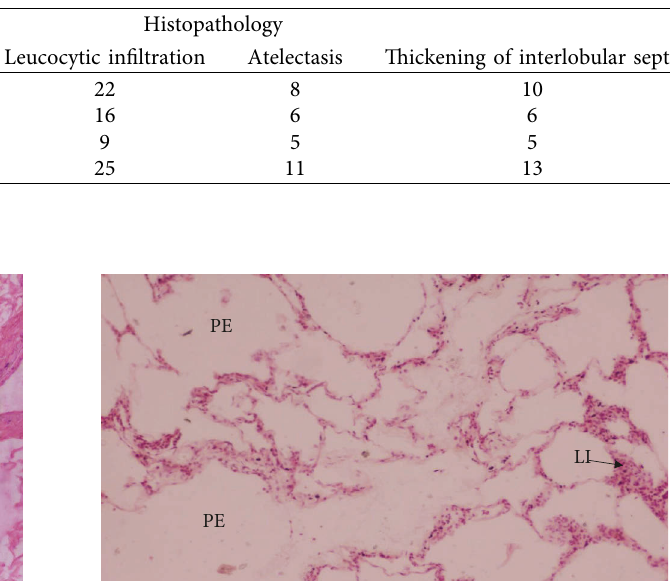
Table 7: Microscopic lesions in naturally infected goats suspected of Mycoplasma capriculom subsp. capripneumoniae across the southern areas of Khyber Pakhtunkwa, Pakistan.